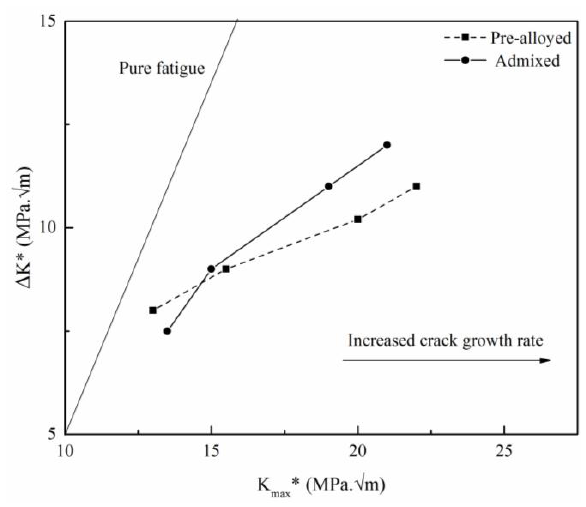
Figure 7. Crack growth trajectory maps of the admixed and pre-alloyed PM steels.